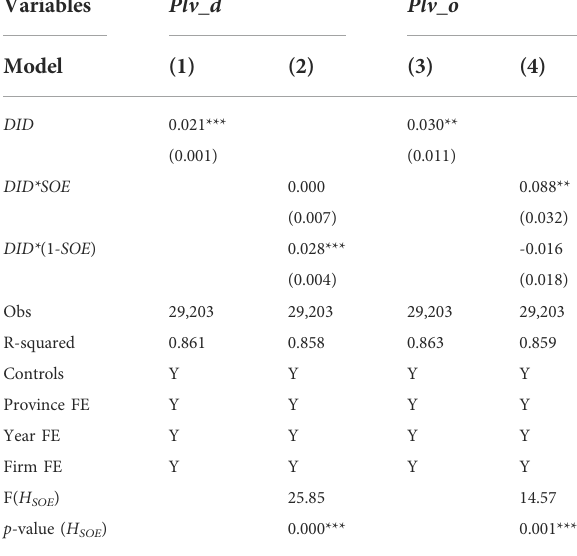
TABLE 11 Industry chain linkage mechanism estimation